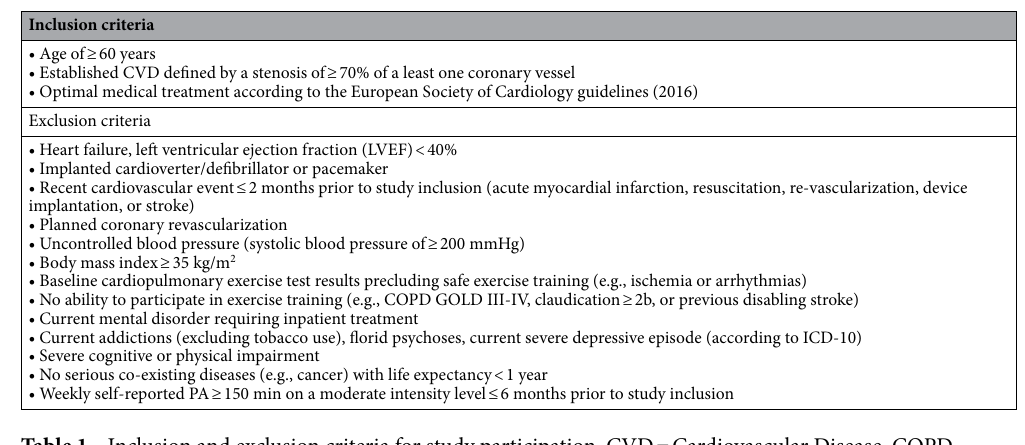
Table 1. Inclusion and exclusion criteria for study participation. CVD = Cardiovascular Disease, COPD GOLD III-IV = Chronic Obstructive Pulmonary Disease stage III according to the Golden Initiative for Chronic Obstructive Lung Disease, ICD-10 = International Statistical Classification of Diseases and Related Health Problems 10th Revision, PA = Physical